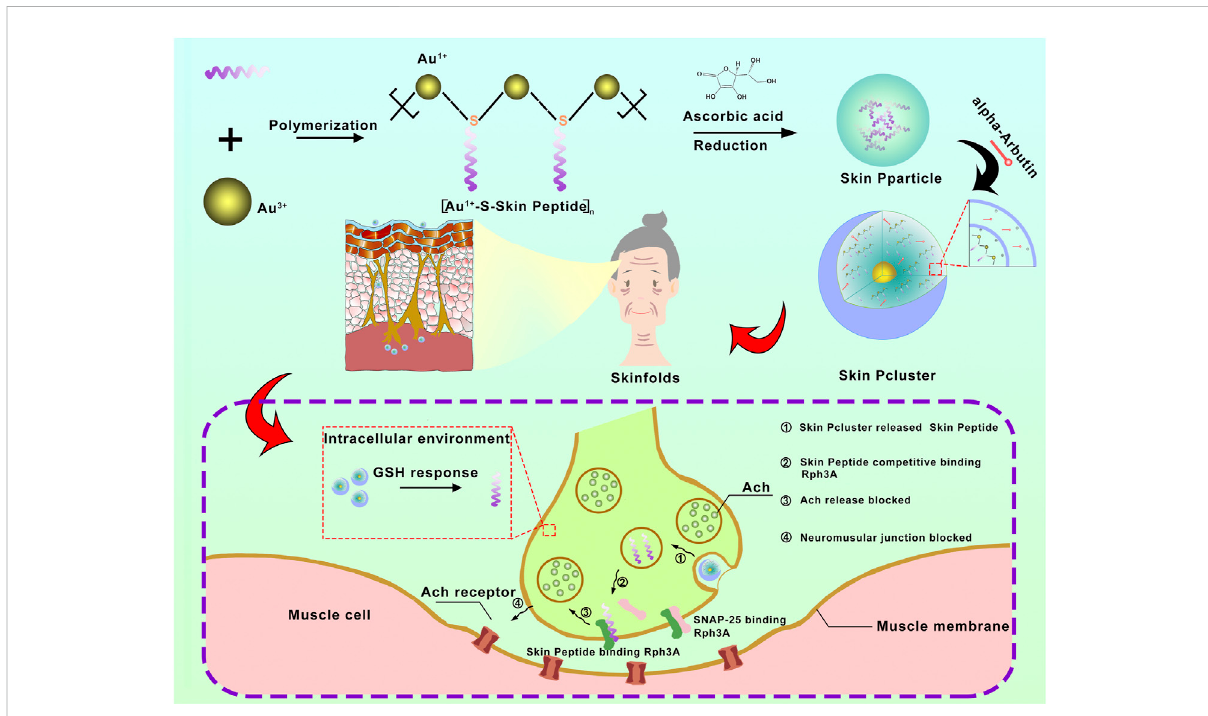
FIGURE 1 The schematic diagram for synthesis and biological function of Skin Pcluster. Firstly, a bionic peptide called Skin peptide was designed and synthesized.Then,thebioavailablepeptide-goldsphericalnano-hybrid,SkinPcluster,wassynthesizedbyself-assemblednanoengineeringstrategy. SkinPcluster,similartobotulinumtoxinandacetylhexapeptide-8,competitivelybindedRph3Atoinhibitthereleaseofacetylcholineandthenreduce wrinkles caused by excessive contraction of